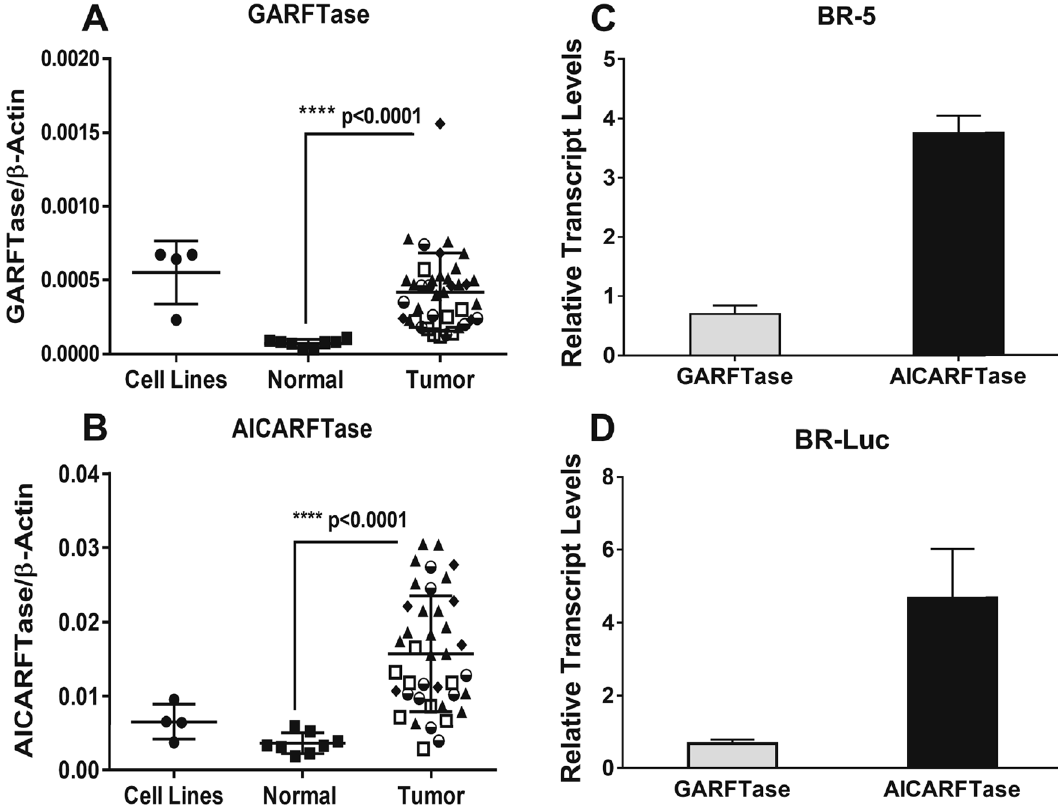
Figure 2. Expression of GARFTase and AICARFTase transcripts in primary EOC patient samples and BR-5 and BR-Luc cells. Transcript levels for GARFTase ( A ) and AICARFTase ( B ) were measured using cDNAs from primary specimens including normal ovary (n = 8) and HGSOC (n = 39) (OriGene) and results were compared to those for EOC cell lines including IGROV1, SKOV3, A2780 and A2780 E-80. Transcript levels were normalized to β-actin transcripts. Statistical analyses were performed between normal samples/tissues and tumor samples/tissues using the Wilcoxon rank-sum test. ( C , D ) Transcript levels of cytosolic C1 metabolic targets (GARFTase and AICARFTase) were determined in the BR-5 and BR-Luc syngeneic mouse models of HGSOC by real-time RT-PCR. Transcripts were normalized to β-actin transcripts and results are shown relative to levels in mouse liver (assigned a value of 1). Results are presented as mean values ± standard errors from at least three experiments. The p values are as follows: **** p < 0.0001. See Supplementary Table S1 for patient characteristics and